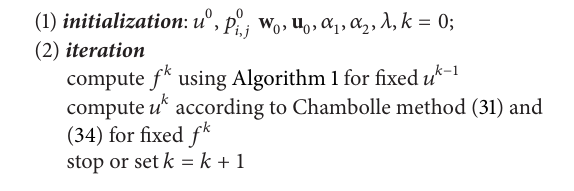
compute 𝑓 𝑘 using Algorithm 1 for fixed 𝑢 𝑘−1